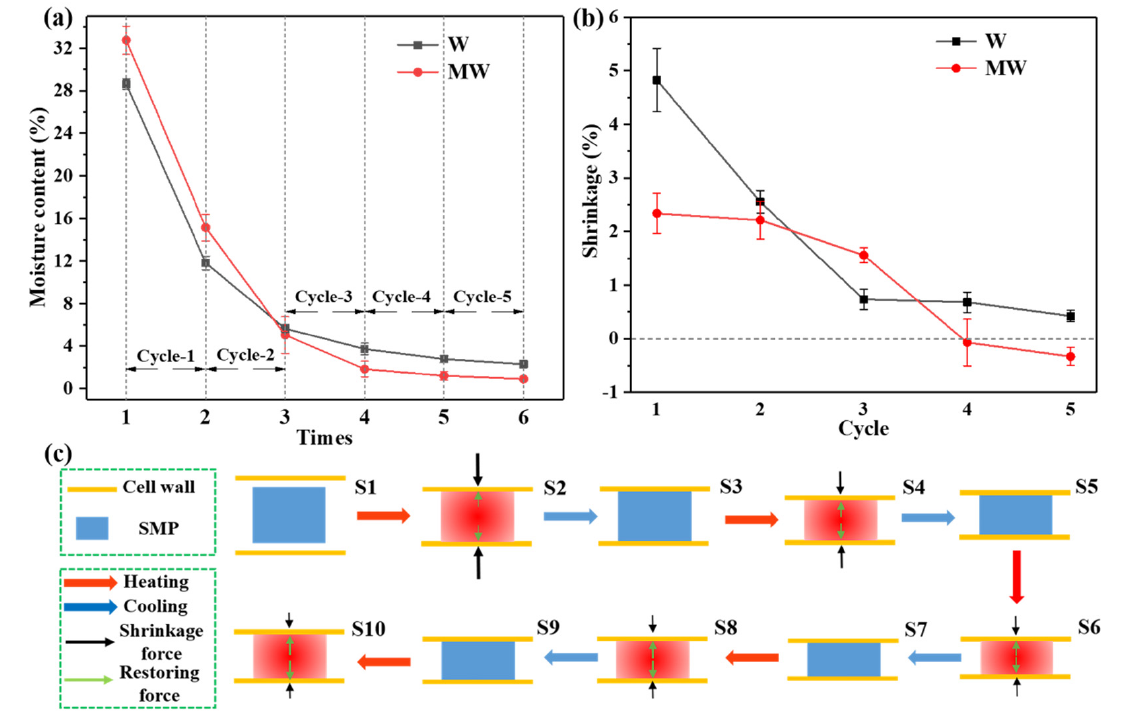
Figure 7. ( a ) The change curve of wood moisture content with heating-cooling cycle. ( b ) The shrinkage of W and MW. ( c ) Schematic illustration of SMP in the wood cell wall.